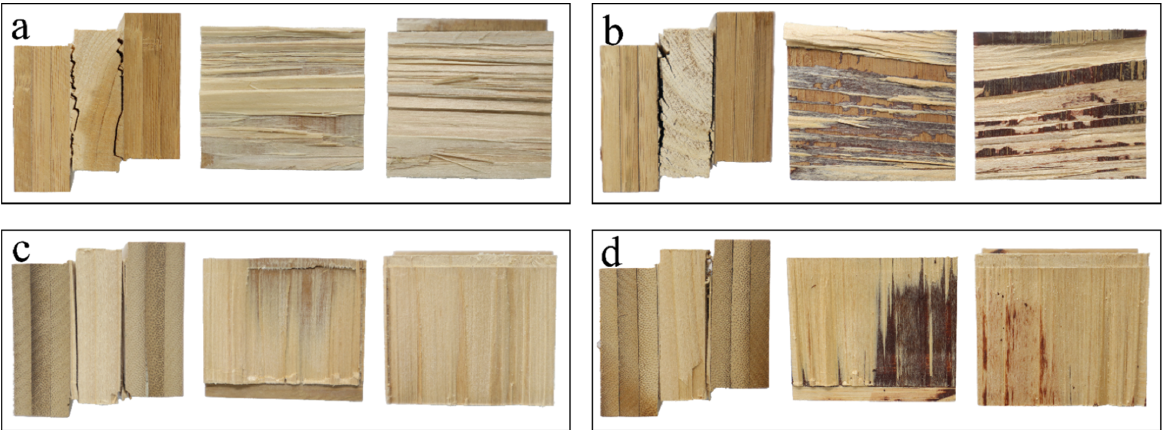
Figure 4. The failure mode of CLBT block shear test: ( a ) PUR specimen loaded in major strength direction; ( b ) PRF specimen loaded in major strength direction; ( c ) PUR specimen loaded in minor strength direction; ( d ) PRF specimen loaded in minor strength direction.